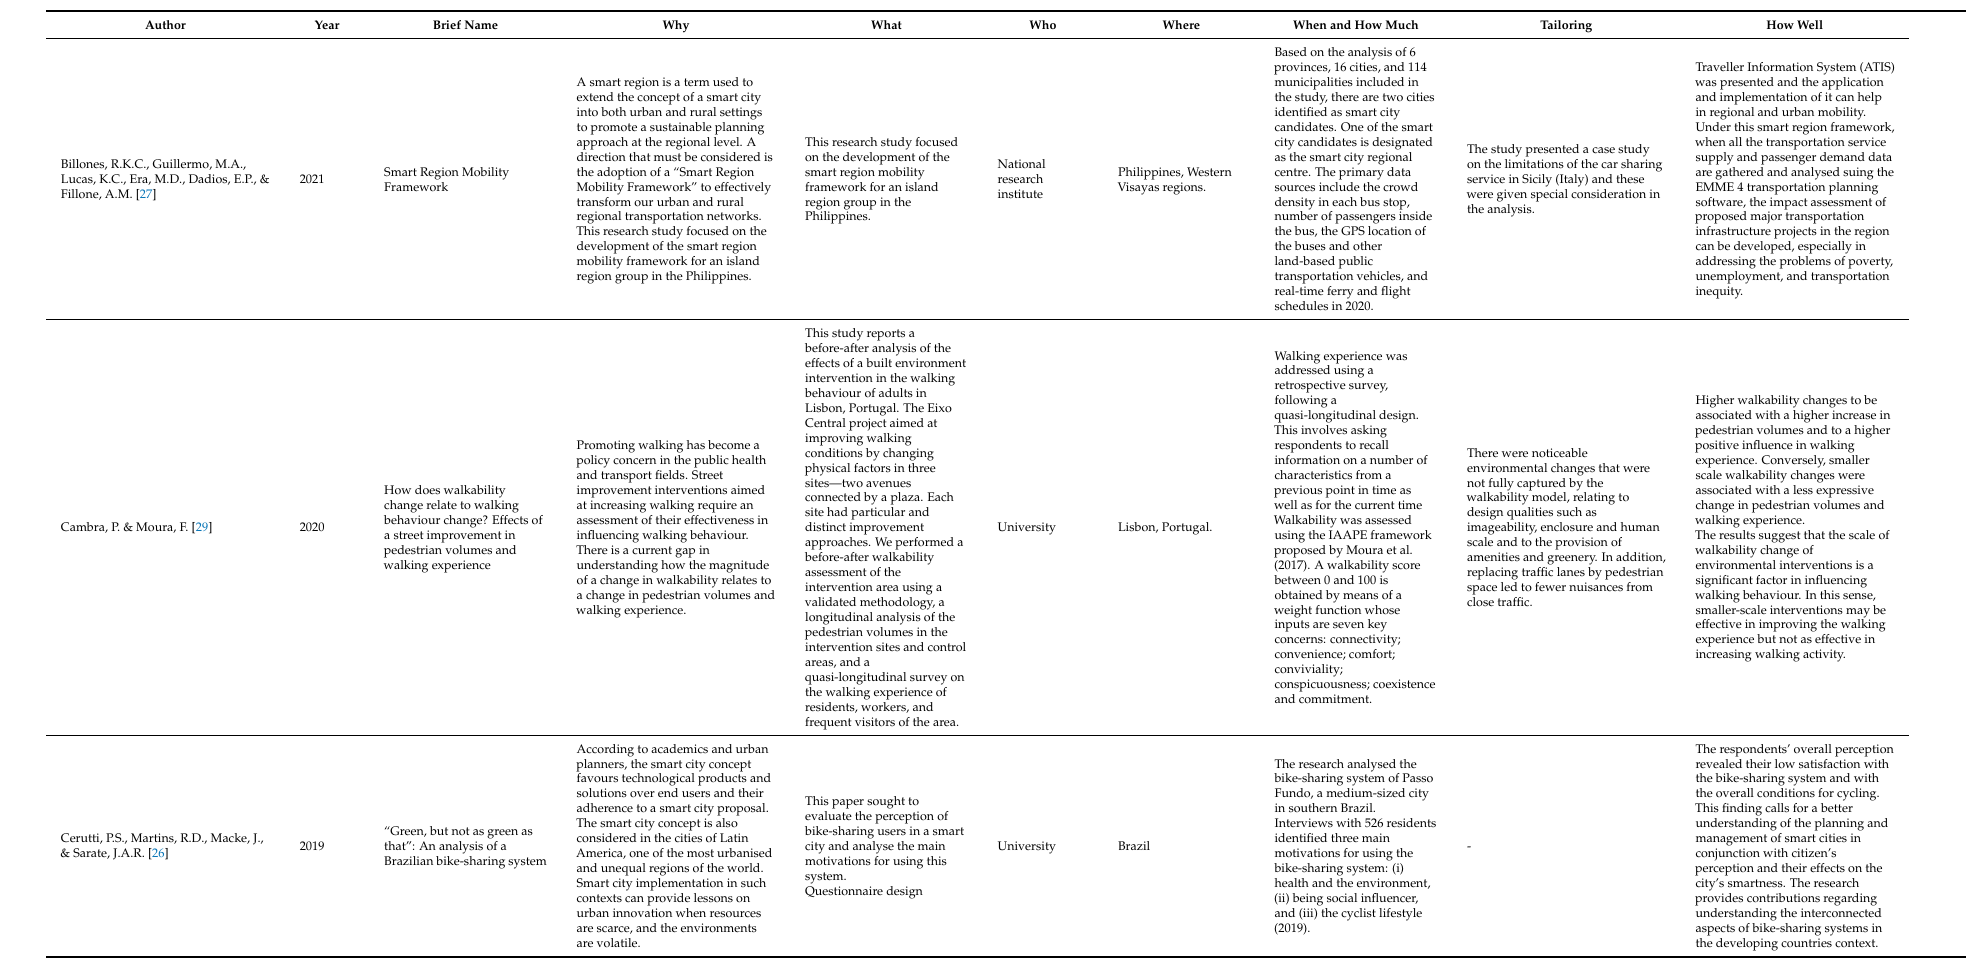
Table A2. TIDieR